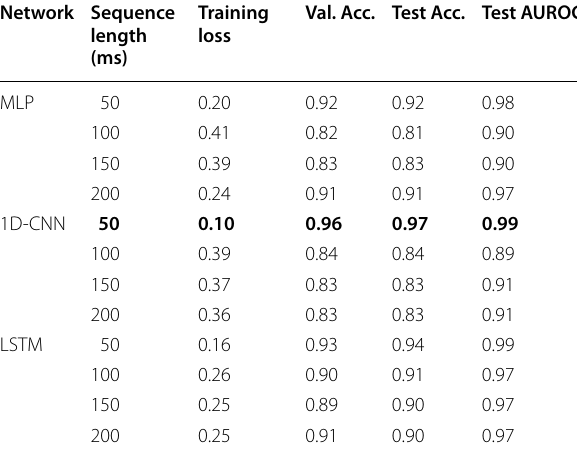
Table 5 First dataset’s results for different architectures and sequence length: training loss, validation accuracy, testing accuracy, and testing